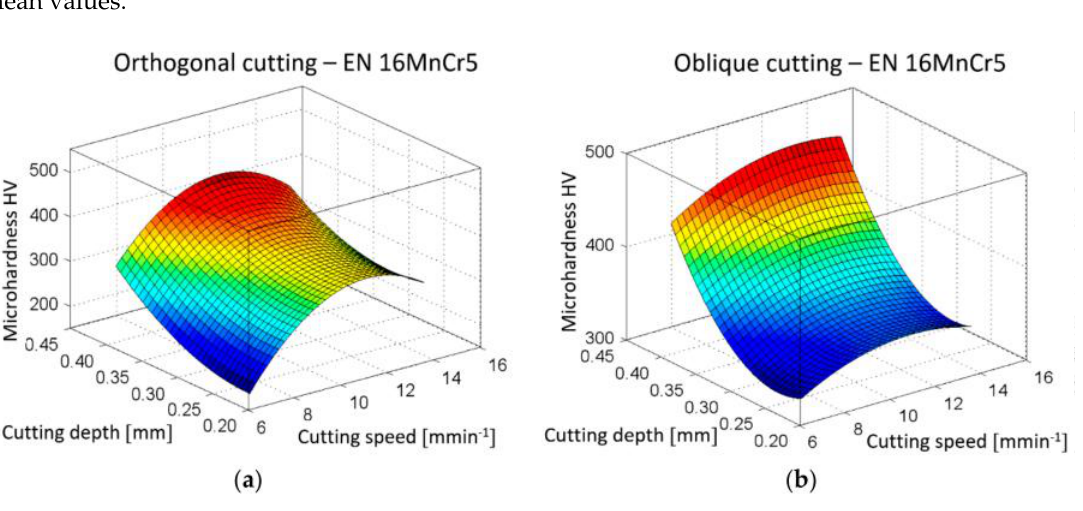
Figure 12. Dependency of microhardness HV on the cutting speed v c and on the cutting depth a p . ( a ) Orthogonal cutting; ( b ) oblique cutting.